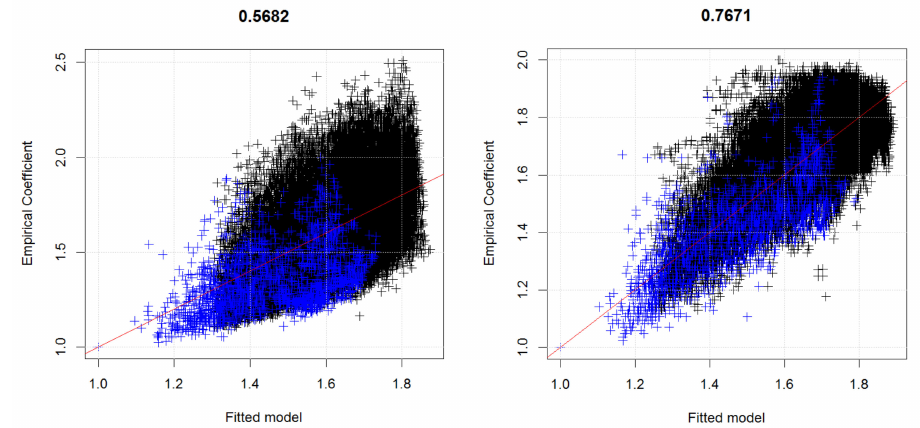
Figure A2. Extremal coe ffi cient θ ( s , t ) obtained by the model with original model of [1] (m = n = 1) against the empirical θ ( s , t ) estimated with the madogram ( left ) and with formula (2) ( right ). The resulting correlation is given on top. Blue dots refer to points for river-connected